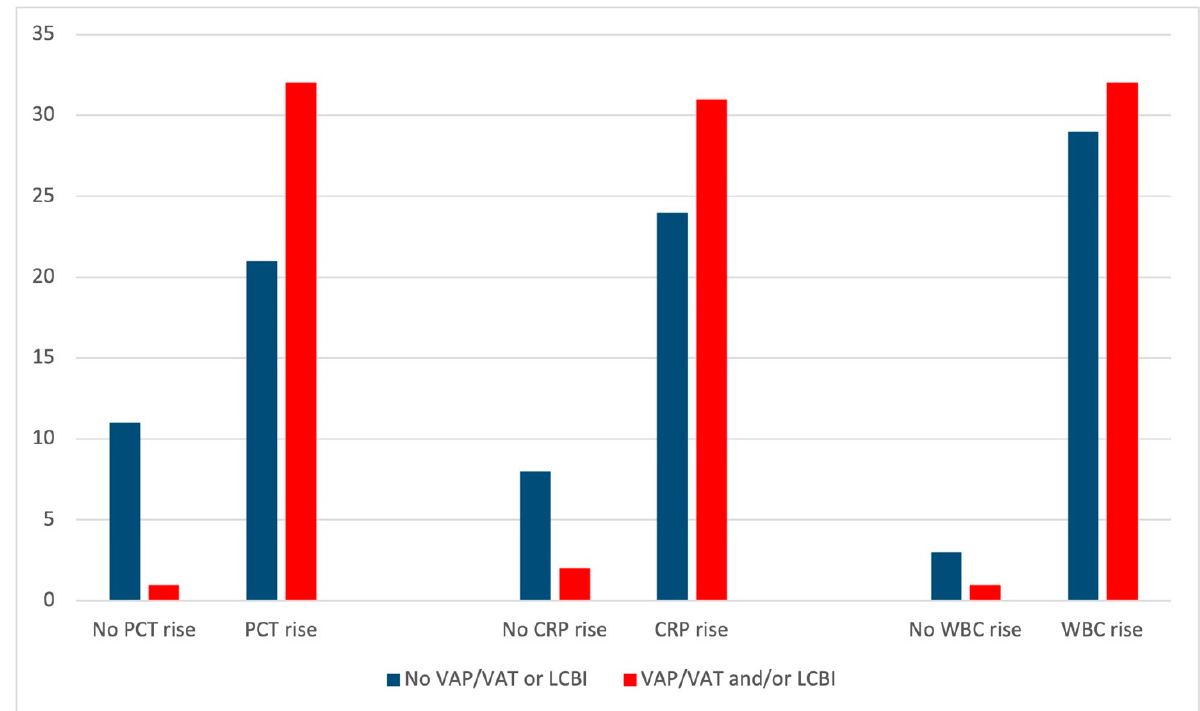
Figure 2. Relative frequencies of patients who experienced a rise in procalcitonin (PCT), C-reactive protein (CRP) and white blood cell count (WBC) in the context of confirmed ventilator-associated pneumonia/tracheobronchitis (VAP/VAT) or laboratory-confirmed bloodstream infection (LCBI).